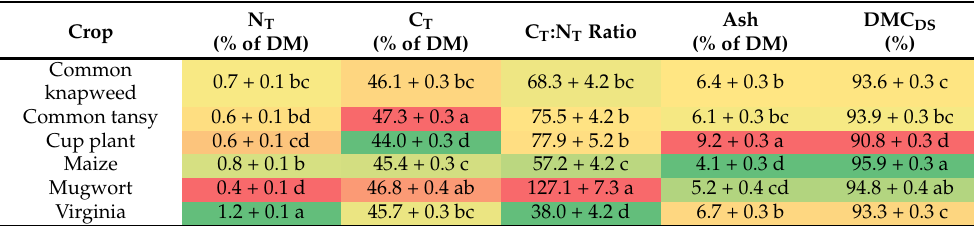
Table 3. Contents of nitrogen, carbon, C T :N T ratio, ash and dry matter content (right before entering the biogas batch test) within the plant material (sorted alphabetically). Additionally, the standard error is provided. The color scaling indicates per parameter the meaning of the value for the use of biomass as biogas substrate from good (dark green) to bad (deep red).